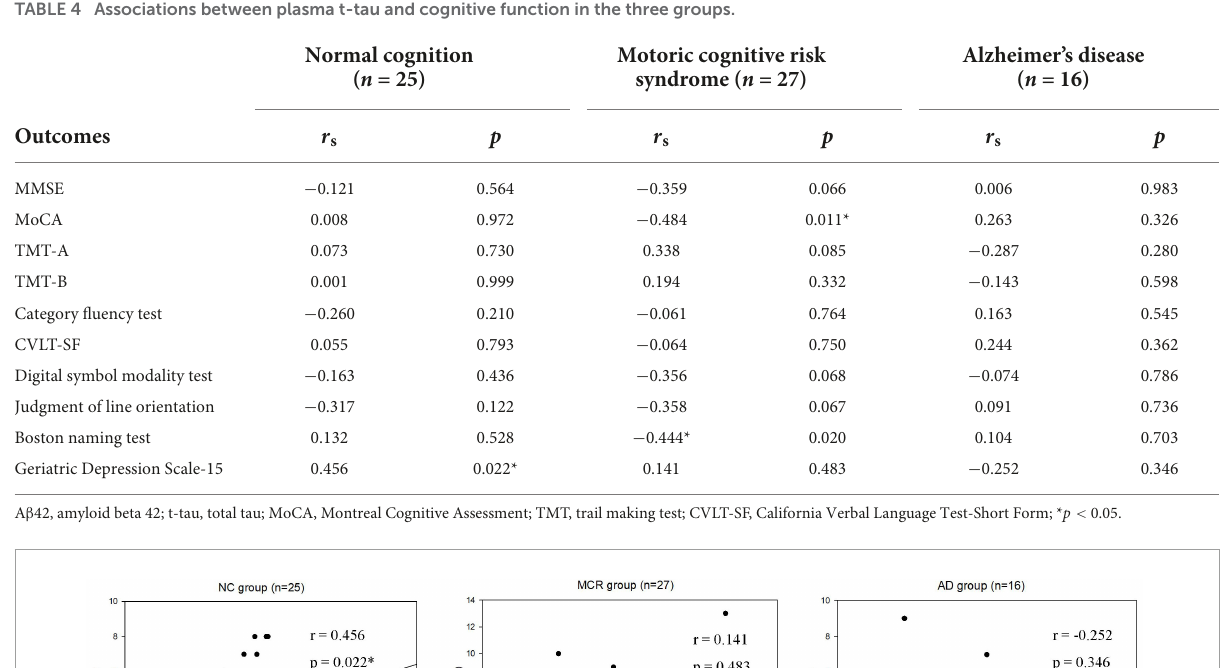
TABLE 4 Associations between plasma t-tau and cognitive function in the three groups.